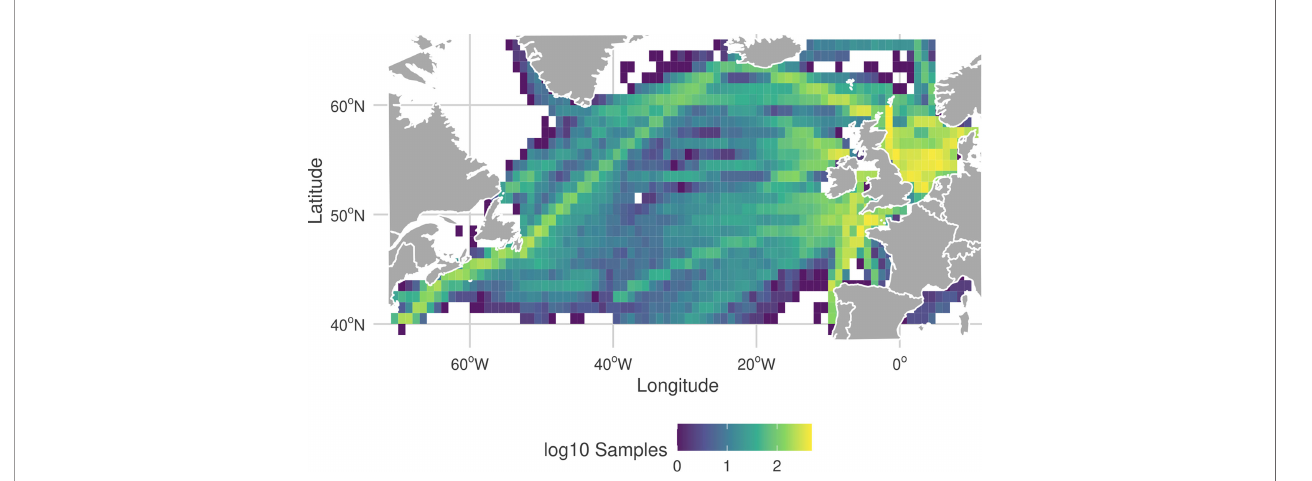
FIGURE 1 | Frequency and location of the CPR samples in the North Atlantic region, from the fi ltered dataset used in this study. More yellow corresponds to a higher frequency of CPR observations in a 1°×1° grid cell. Color scale of the frequencies are on a log 10